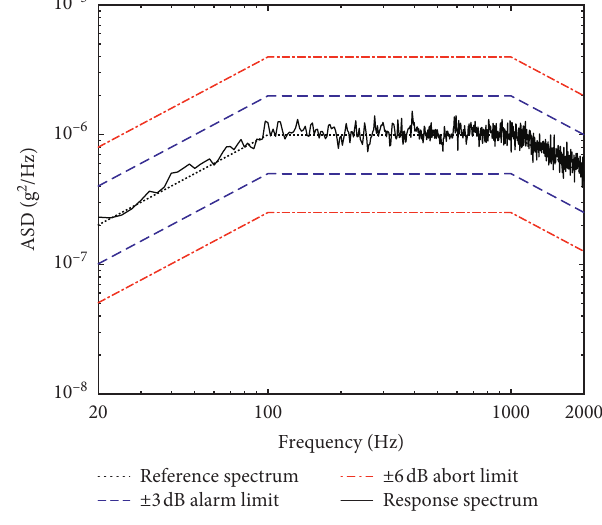
Figure 8: ASD of the control point.